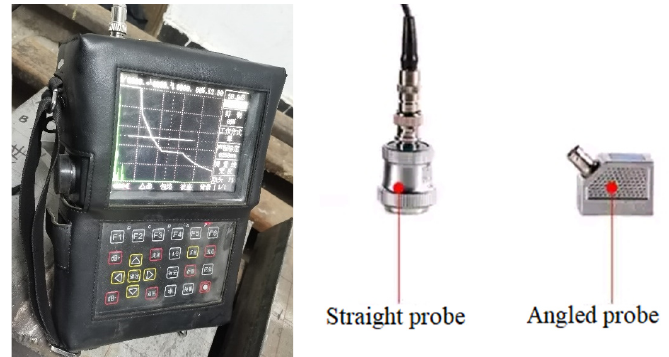
Figure 6. Ultrasonic flaw detector and probe.